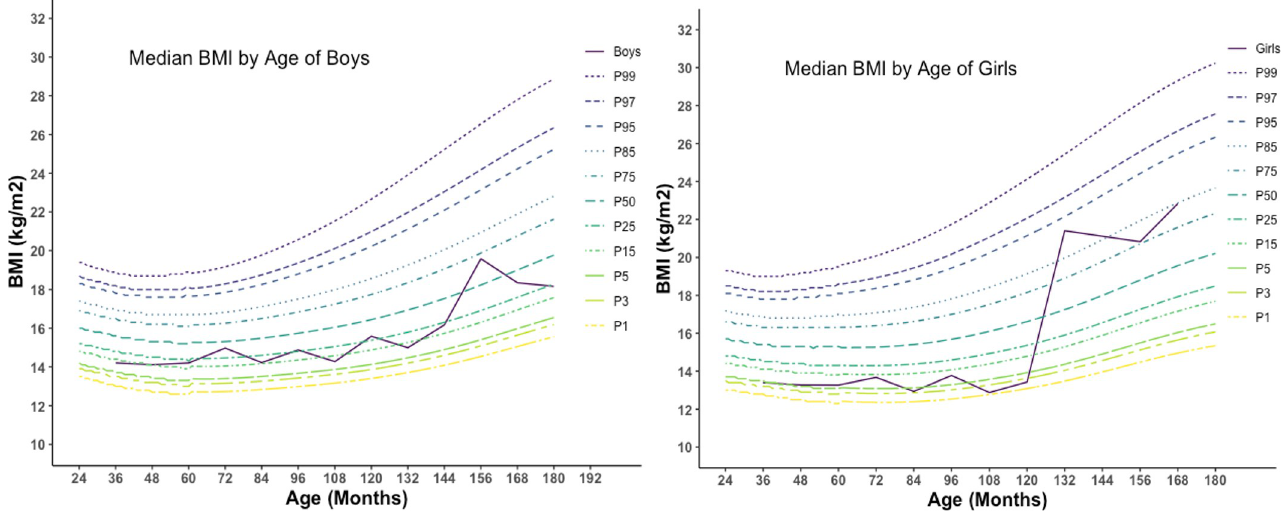
Fig 6. BMI for age percentile for boys and girls (n = 330) [Graphs was generated using R]. https://doi.org/10.1371/journal.pone.0257055.g006 PLOS ONE | https://doi.org/10.1371/journal.pone.0257055 September 9,